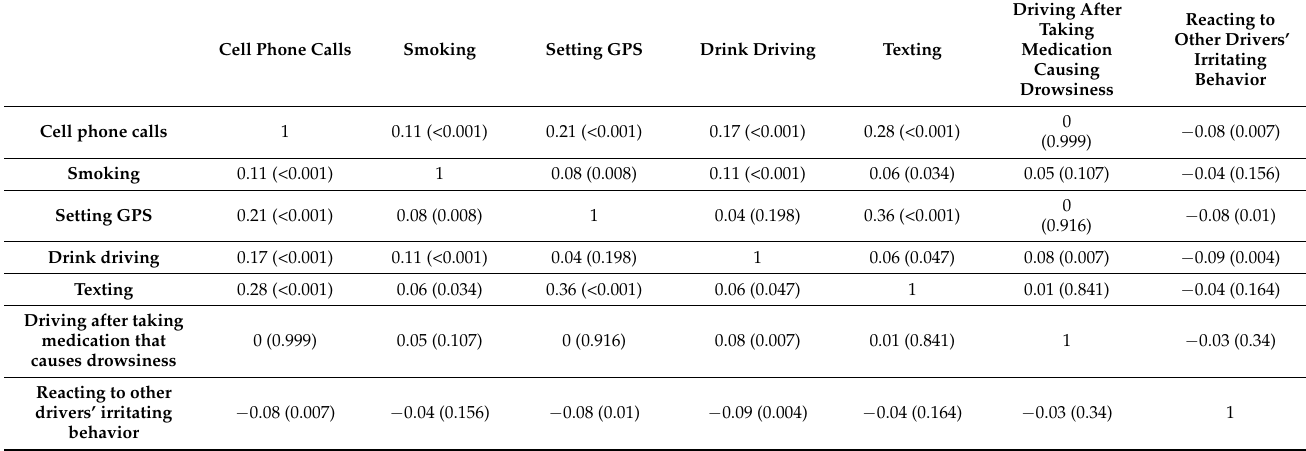
Table A1. Spearman correlation coefficients between behavior that limits concentration and their corresponding p